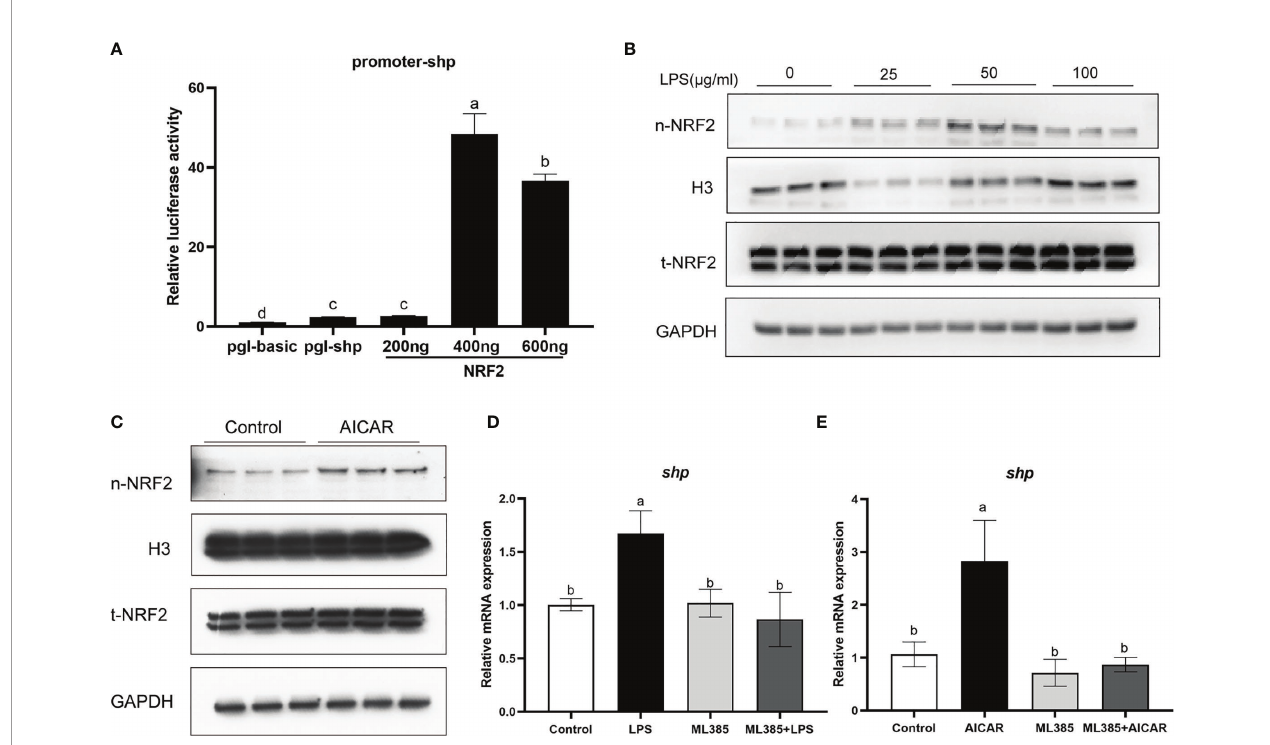
FIGURE 9 | NRF2 is involved in the effect of LPS and AMPK pathway on SHP. (A) Relative luciferase activities of SHP promoter of large yellow croaker in HEK 293T cells after NRF2 overexpression. (B) Immunoblots for nuclear NRF2 in macrophages after LPS stimulation. (C) Immunoblots for nuclear NRF2 in macrophages after treatment with AMPK activator (AICAR). (D) Expression of shp in macrophages after treatment with LPS and NRF2 inhibitor (ML385). (E) Expression of shp in macrophages after treatment with AICAR and ML385. Data are presented as means ± SEMs, n = 3 replicate experiments. Signi fi cance was evaluated by one-factor ANOVA followed by Duncan ’ s multiple range test. Labeled means without a common letter differ, P < 0.05. AICAR, 5-aminoimidazole-4-carboxamide ribonucleotide; LPS, lipopolysaccharide; SHP, small heterodimer partner; GAPDH, glyceraldehyde-3-phosphate dehydrogenase. NRF2, nuclear factor-erythroid 2-related factor